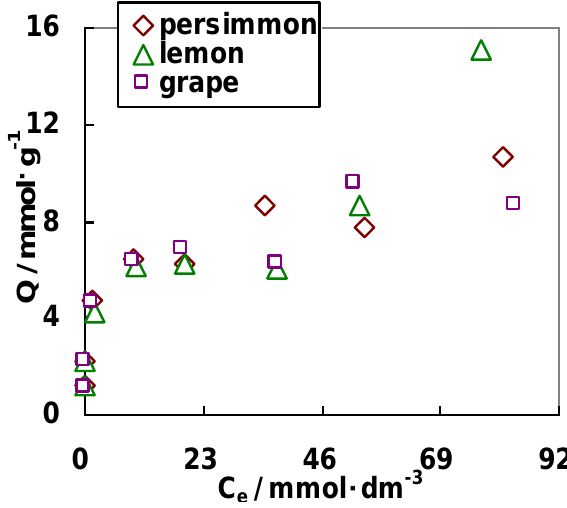
Figure 26. Adsorption isotherms of gold(III) from 1 mol·dm −3 hydrochloric acid solution on the adsorption gels prepared from peels of persimmon, lemon and grape treated in boiling concentrated sulfuric acid [34] (with permission for reuse from Elsevier B.V.).